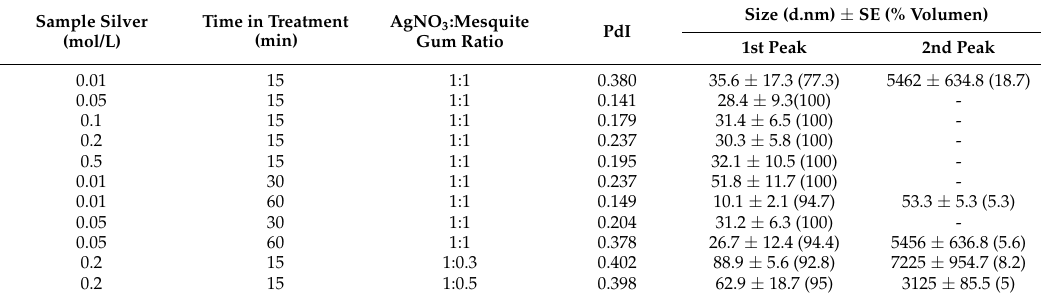
Table 3. Follow-up of the colloidal stability of Ag NPs samples synthesized at different conditions after three months of synthesis: hydrodynamic diameter (DLS